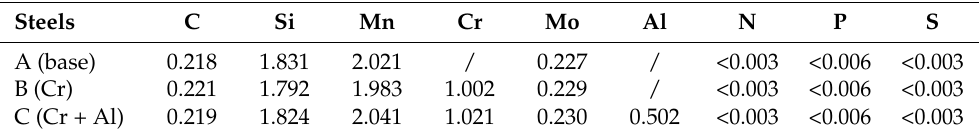
Table 1. The chemical compositions of steels (wt